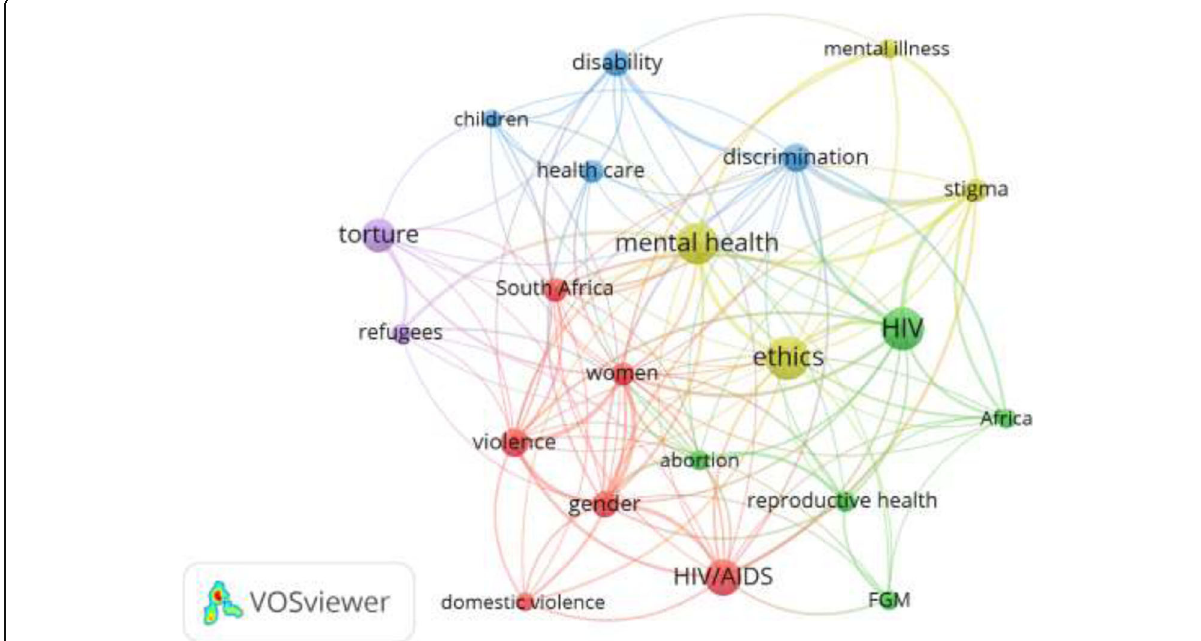
Fig. 2 Network visualization map of keywords with minimum occurrences of 30 times. The size of the circle is a relative representation of number of occurrences with larger size indicating higher frequency of